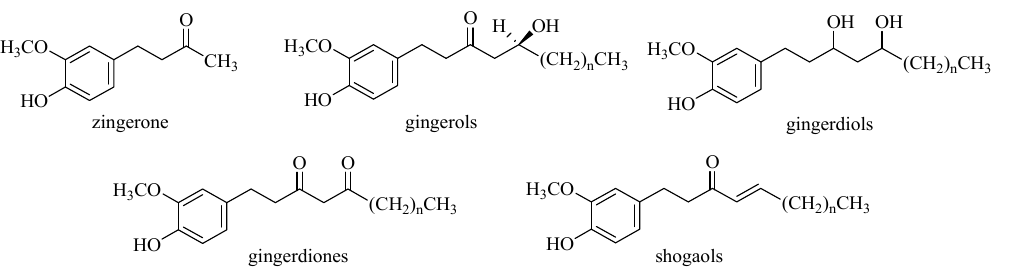
Figure 1. Chemical structures of the pungent principles from the rhizomes of Zingiber officinale .